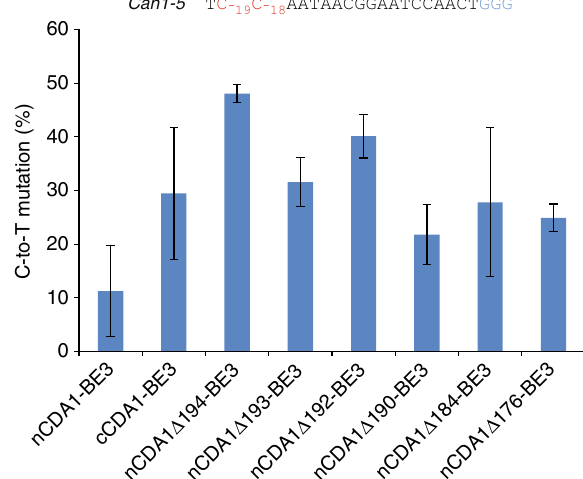
Fig. 6 Analysis of base editing patterns and ef fi ciencies in single yeast colonies selected for canavanine resistance. A comparison of base editing frequencies for nCDA1-BE3, cCDA1-BE3, and selected base editors with truncated CDA1 domains is shown. Yeast cells were transformed with plasmids expressing the base editor and an sgRNA targeting the Can1 – 5 site. The target sequence is shown with the cytidines that can potentially undergo editing in red and the PAM in blue. If C-to-T conversion occurs at position − 18 or − 19 or both, the Can1 gene will be inactivated and the cell becomes resistant to canavanine. Values and error bars re fl ect the mean and standard deviation of three biological replicates. Source data are provided as a Source Data fi le. See also Table